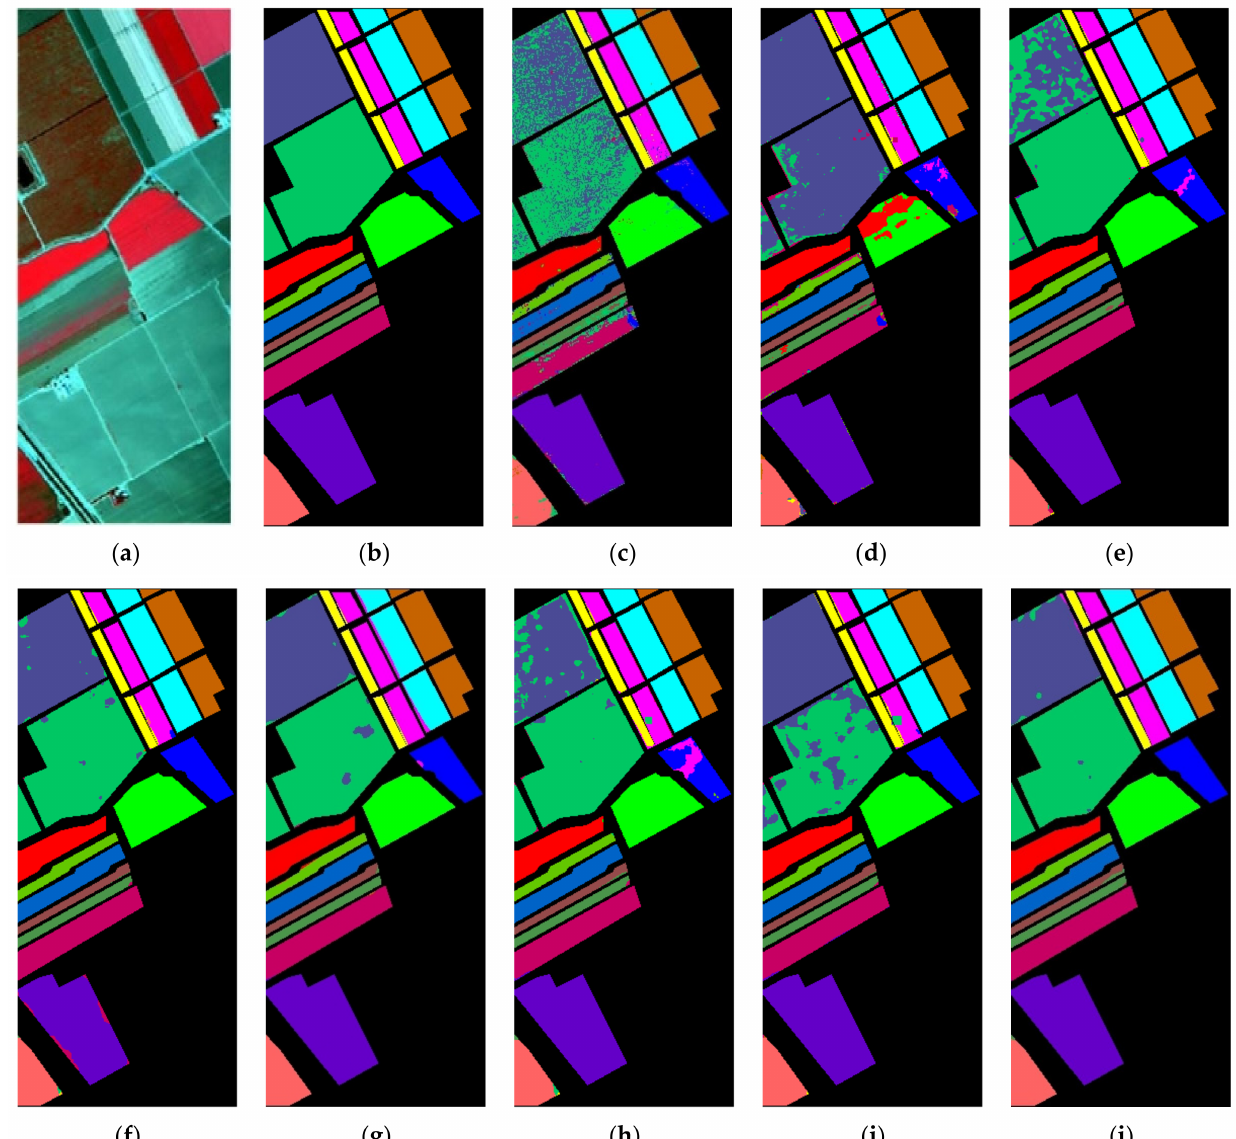
Figure 7. Classification maps for SA dataset using 1% training samples. ( a ) False-color image; ( b ) ground truth; ( c ) SVM (OA: 86.89%); ( d ) CDCNN (OA: 76.84%); ( e ) SSRN (OA: 93.43%); ( f ) FDSSC (OA: 98.52%); ( g ) HybridSN (OA: 98.33%); ( h ) DBMA (OA: 95.86%); ( i ) DBDA (OA: 95.53%); ( j ) proposed method (OA: